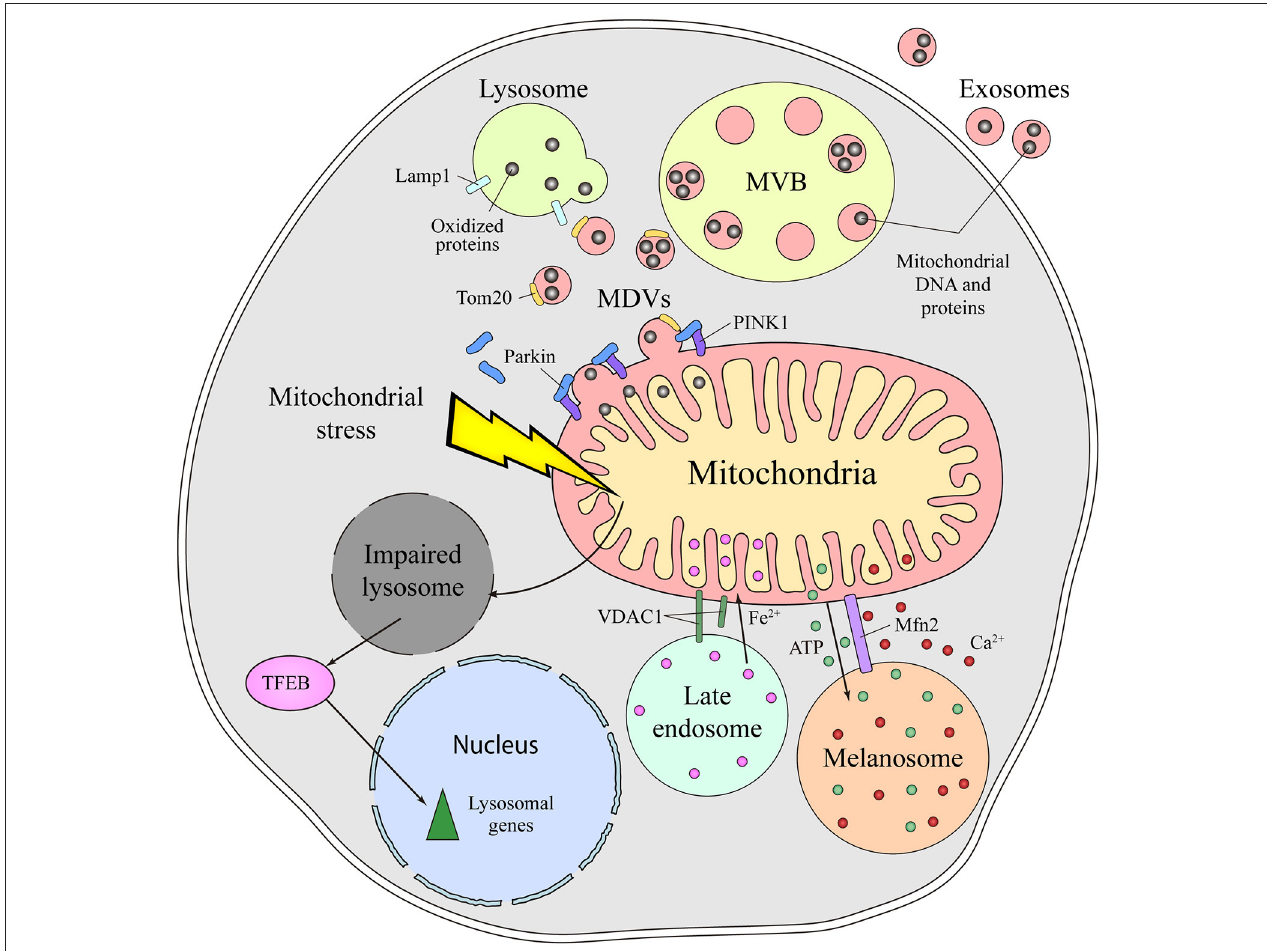
FIGURE 2 | Different means of communication between the mitochondria and lysosome in mammals. Emerging evidence supports the existence of intense crosstalk between the mitochondria and the endolysosomal compartment in mammals. Functional stress or dysfunction of one organelle affects the other. Thus, mitochondrial stress induces a secondary lysosomal dysfunction, which produces activation of TFEB and a transcriptional response associated with lysosomal biogenesis. Additionally, under conditions of stress, mitochondrial derived vesicles (MDVs) are formed in a process dependent on parkin and PINK1. These MDVs traffic obsolete mitochondrial proteins into the endolysosomal system for their degradation, a fast response established to remove oxidized proteins. Once in the endolysosomal route, the mitochondrial content can be degraded by lysosomal enzymes or released to the extracellular milieu via exosomes. Physical connections between the mitochondria and lysosome or melanosome are required for local ATP supply, Ca 2 + homeostasis, Fe 2 + transport and to process VDAC1. Mfn2 regulates the mitochondria-melanosome physical connection. MVB, Multivesicular body; MDVs, Mitochondrial-derived vesicles; PINK1, PTEN-induced kinase 1; VDAC1, mitochondrial voltage-dependent anion channel isoform 1; Mfn2, Mitofusin2; TFEB, Transcription Factor